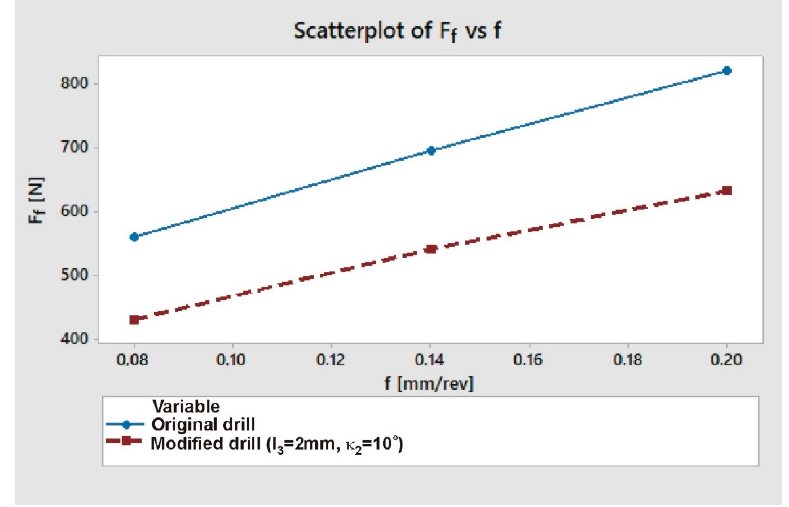
Figure 12. Axial drilling force F f as a function of feed f for factory and modified drills.